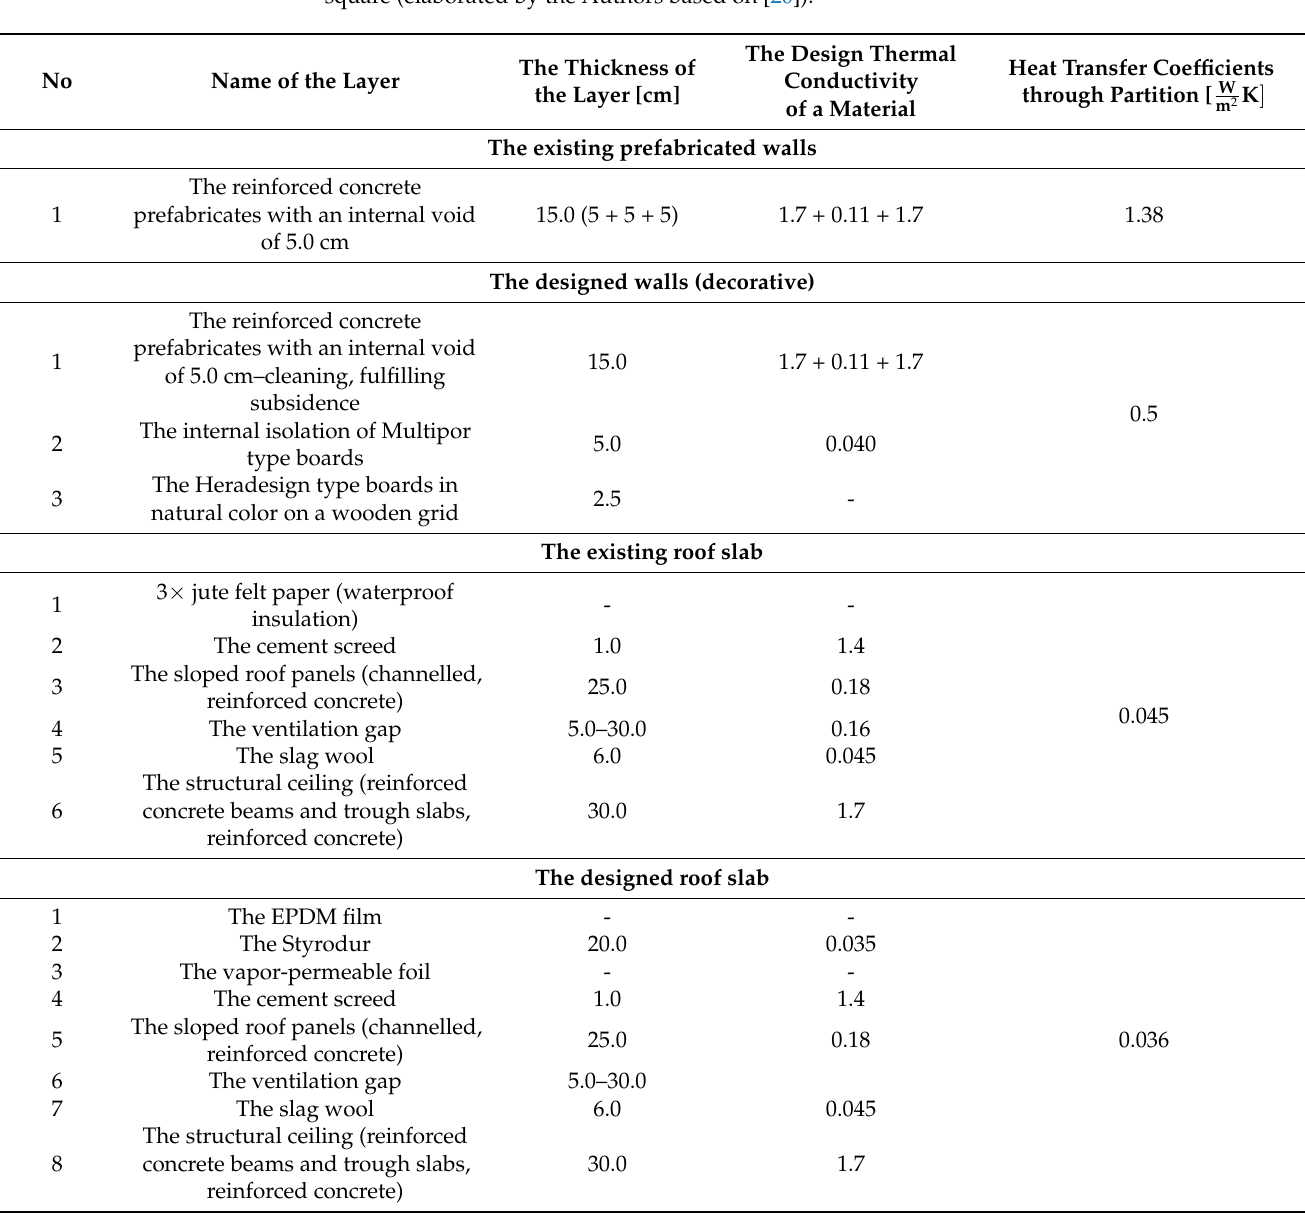
Table 3. The thermal modernisation building solutions for the commercial pavilion at Grunwaldzki square (elaborated by the Authors based on